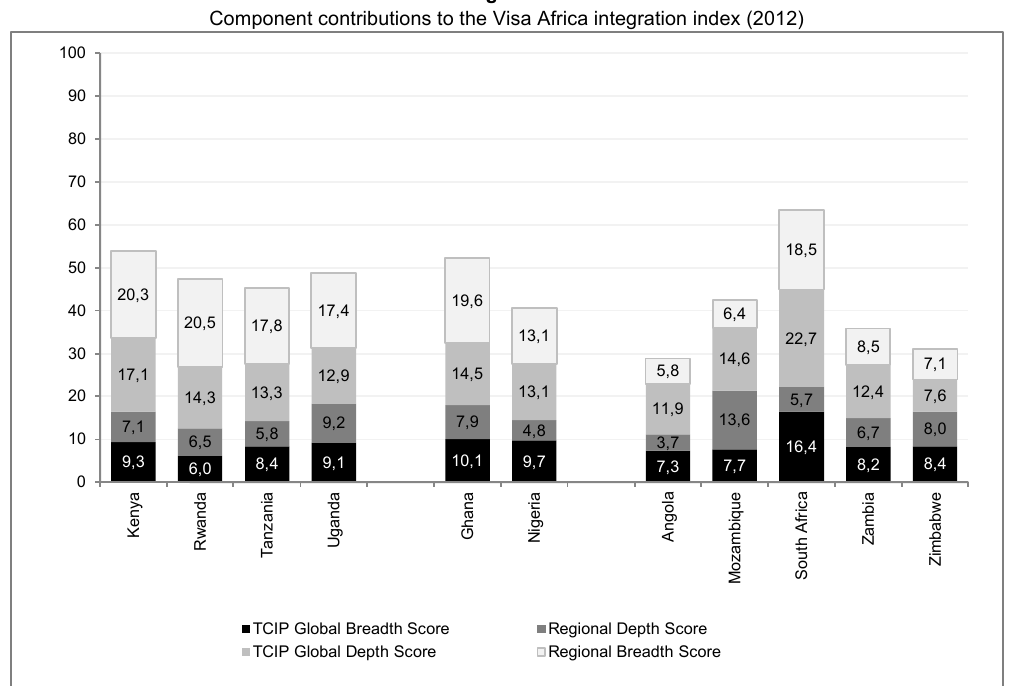
Component contributions to the Visa Africa integration index